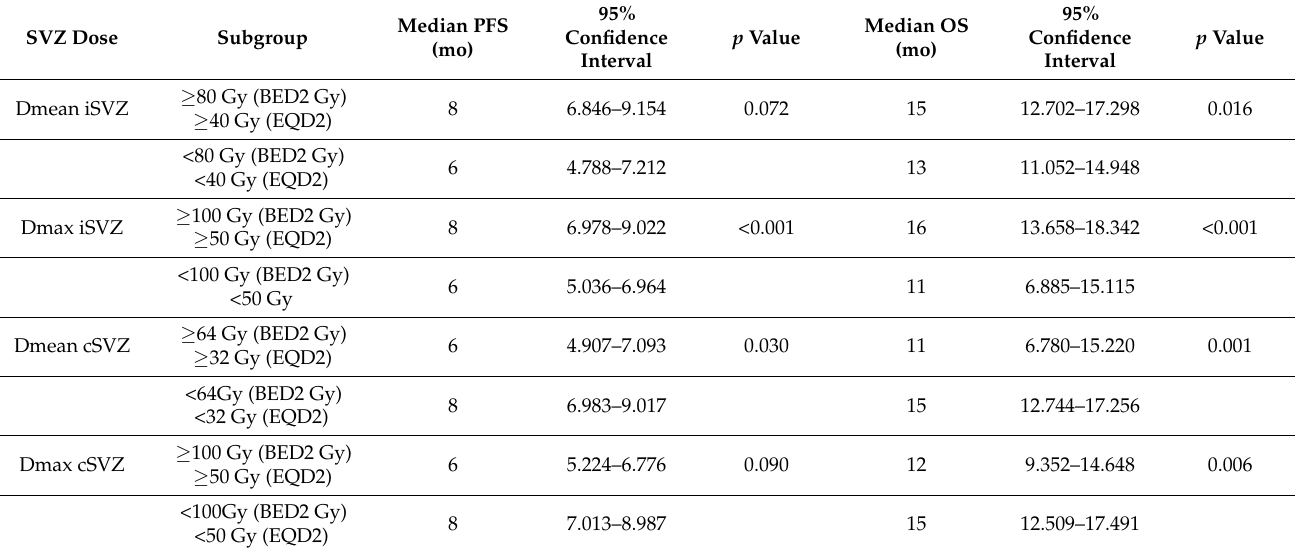
Table 4. SVZ dose distribution and